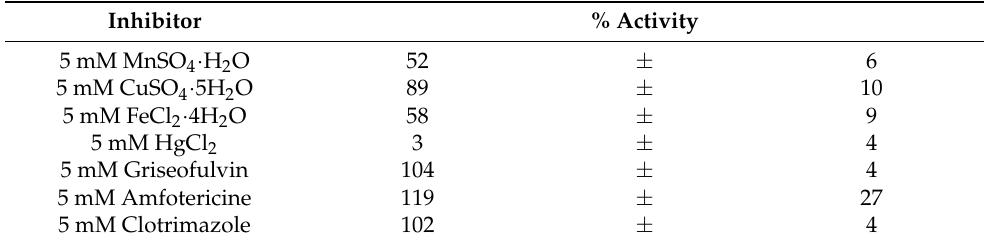
Table 3. Inhibition data for crChit62J4. Measured with 2 mM pNGG as a substrate, 2.7 µ g/mL crChit62J4, at 37 ◦ C and pH 5.5. The relative values of activity compared to values without added compounds under the same conditions and standard deviations are given.